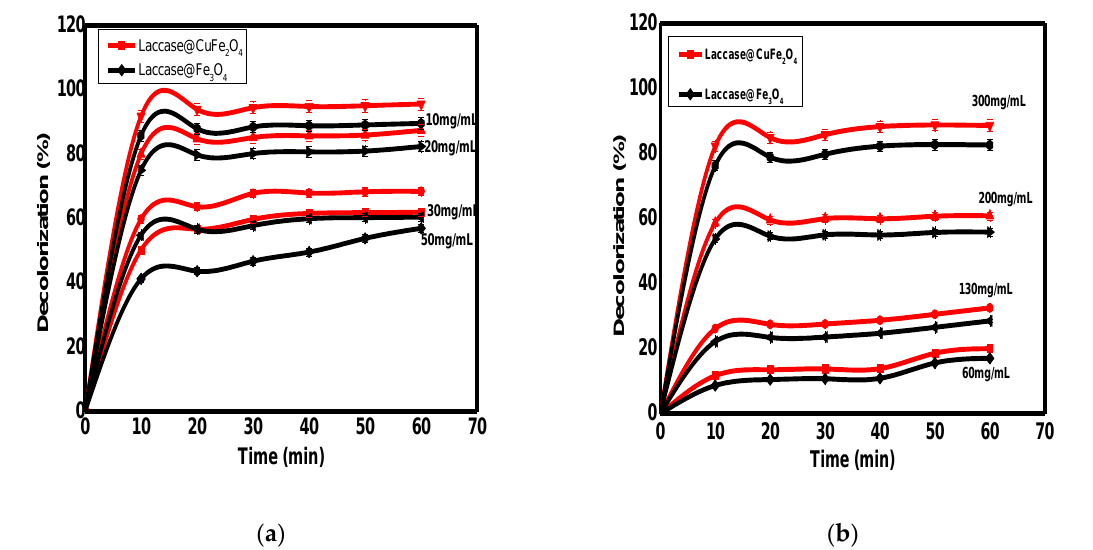
Figure 4. The effect of dye concentration ( a ) and the effect of nano-biosorbent dosage ( b ) for DR23 degradation using Fe 3 O 4 and CuFe 2 O 4 nanoparticle-immobilized laccase.